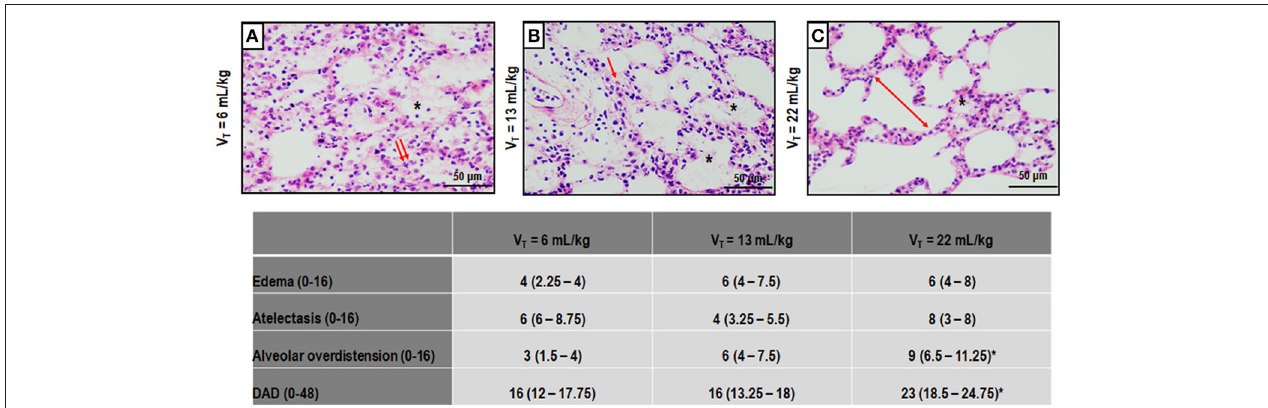
FIGURE 3 | Photomicrographs (light microscopy) of lung parenchyma stained with hematoxylin and eosin. The following groups were analyzed: (1) V T = 6 mL/kg and RR adjusted to normocapnia (A) ; (2) V T = 13 mL/kg (B) ; (3) V T = 22 mL/kg (C) . In the second and third groups, RR was adjusted to yield mechanical power comparable to that in the first group. Asterisks show alveolar/interstitial edema; arrows indicate alveolar collapse, and double arrows, areas of alveolar overdistension. Photomicrographs are representative of data obtained from lung sections of seven animals (original magnification, 200 × ). Bars = 100 µ m . Cumulative diffuse alveolar damage (DAD) score representing injury from alveolar/interstitial edema, atelectasis, and alveolar overdistension. Values are median (interquartile range) of 7 animals/group. *vs. V T = 6 mL/kg ( p < 0.05).